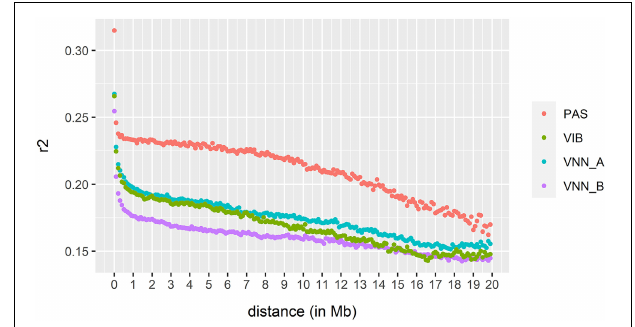
FIGURE 5 | Extent of linkage disequilibrium estimated in two European sea bass commercial cohorts VNN_A and VNN_V challenged to NNV, one European sea bass commercial cohort VIB challenged to V. harveyi and one gilthead sea bream commercial cohort PAS challenged to Photobacterium damselae subsp. piscicida